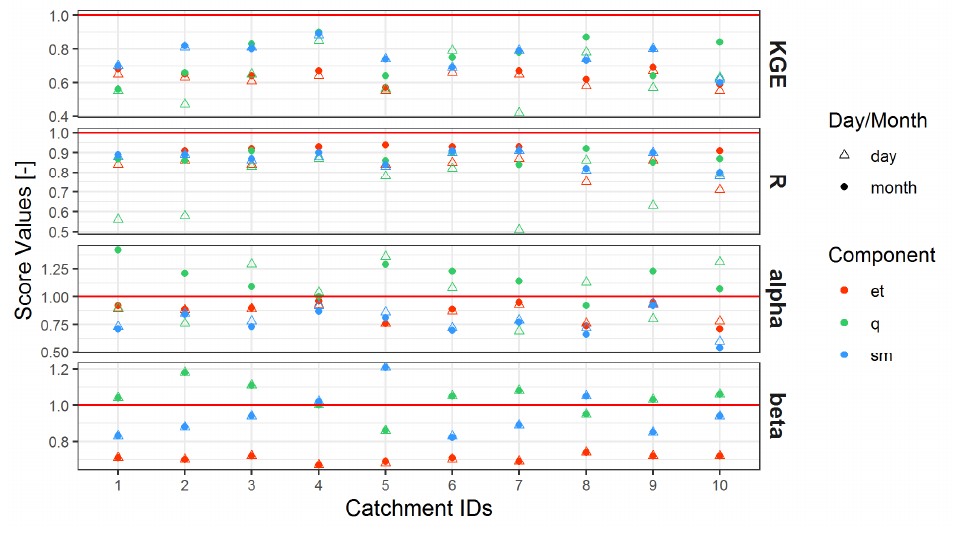
Figure 6. Skill scores of water balance components (ET = et, Q = q, SM = sm) for ten selected catchments on a daily and monthly scale.